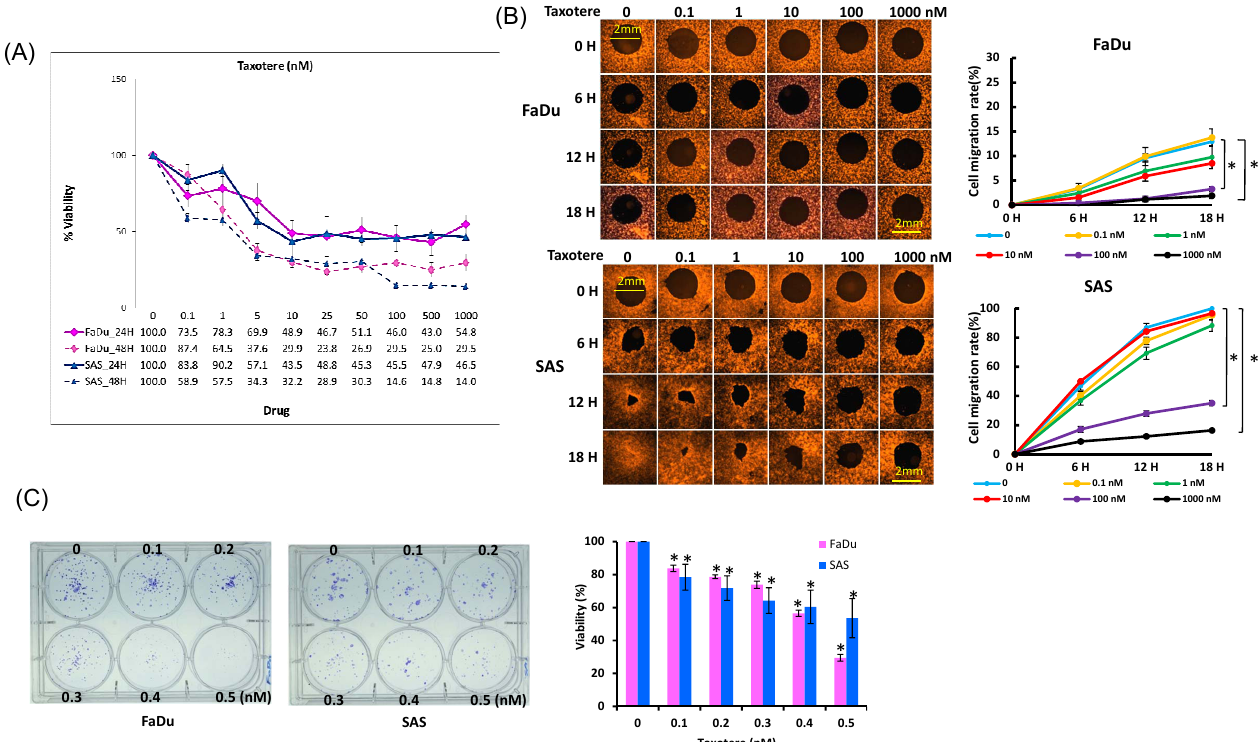
Figure 2. Effects of docetaxel on cell growth and migration. Cells were treated at concentrations ranging from 0.1 to 1000 nM of docetaxel for 24 or 48 h and then treated with WST1 for 3 h. ( A ) FaDu and SAS cell viability was measured by WST-1. Results are the mean ± SD for six independent experiments. ( B ) FaDu and SAS cells were treated at concentrations ranging from 0.1 to 1000 nM of docetaxel for 6 to 18 h, and cell migration was determined by Oris™ Cell Migration Assay. Data are expressed as mean ± SEM ( n = 6), * p < 0.05. ( C ) FaDu and SAS cells were treated at concentrations ranging from 0.1 to 0.5 nM of docetaxel for 10 days, and colony formation was determined by clonogenic assay. Results are the mean ± SD ( n = 6), * p < 0.05 vs.